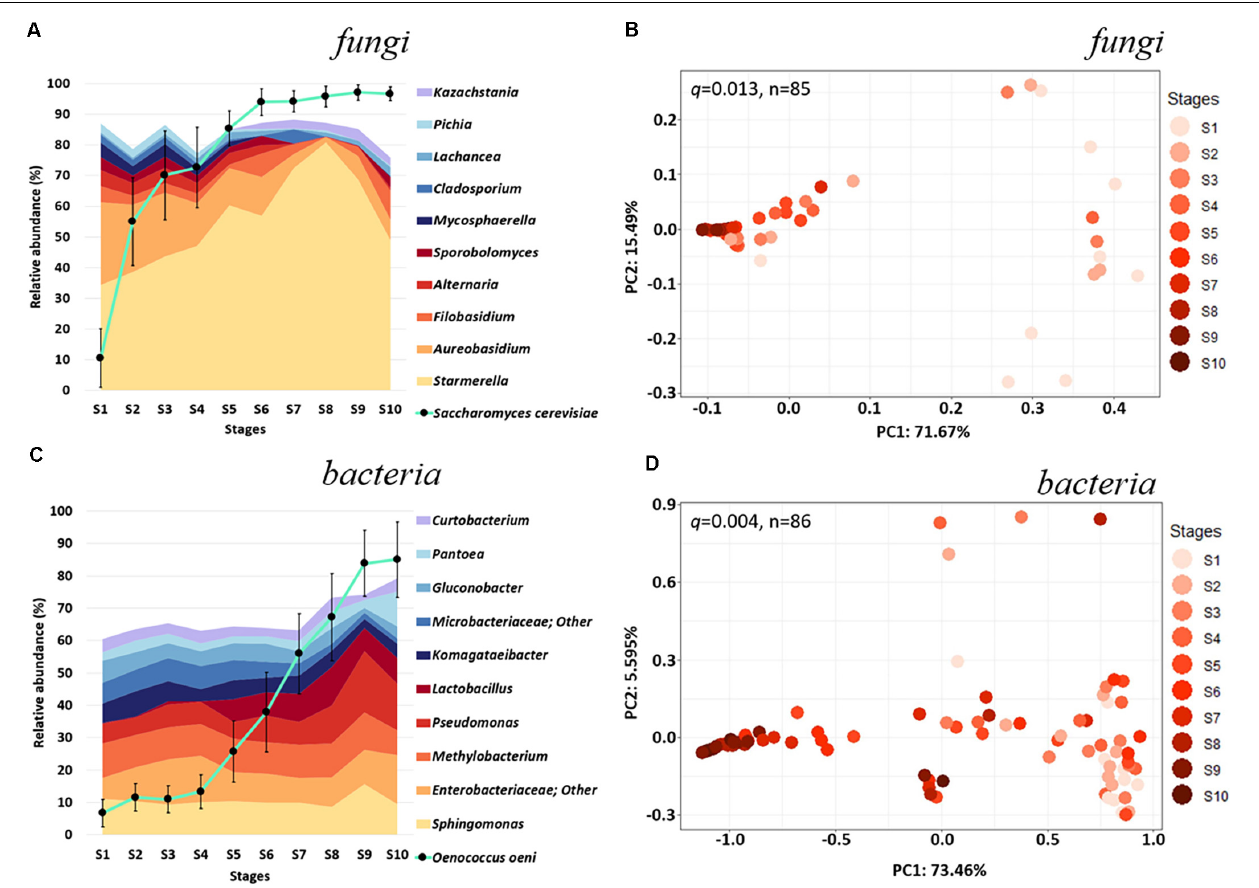
FIGURE 1 | Microbial diversity across fermentation stages of Chambourcin red wine. Relative taxonomic distribution at the genus level displaying the top 10 (A) fungal and (C) bacterial community abundance throughout fermentation minus Saccharomyces cerevisiae and Oenococcus oeni ( • connected by turquoise line). Taxonomic distributions for each timepoint represent the average abundance of microbial taxa detected in all samples from each fermentation stage. Weighted UniFrac PCoA for (B) fungal ( n = 85) and (D) bacteria ( n = 86) communities categorized by fermentation stages. Relative abundances of S. cerevisiae and O. oeni were obtained from their reads normalized to total sample reads. Error bars in (A,C) denote variance (Standard Error of the Mean, SEM) of S. cerevisiae and O. oeni abundances. Statistical significance for was determined by PERMANOVA ( n = 999; Figures 1B,D and Supplementary Table 3